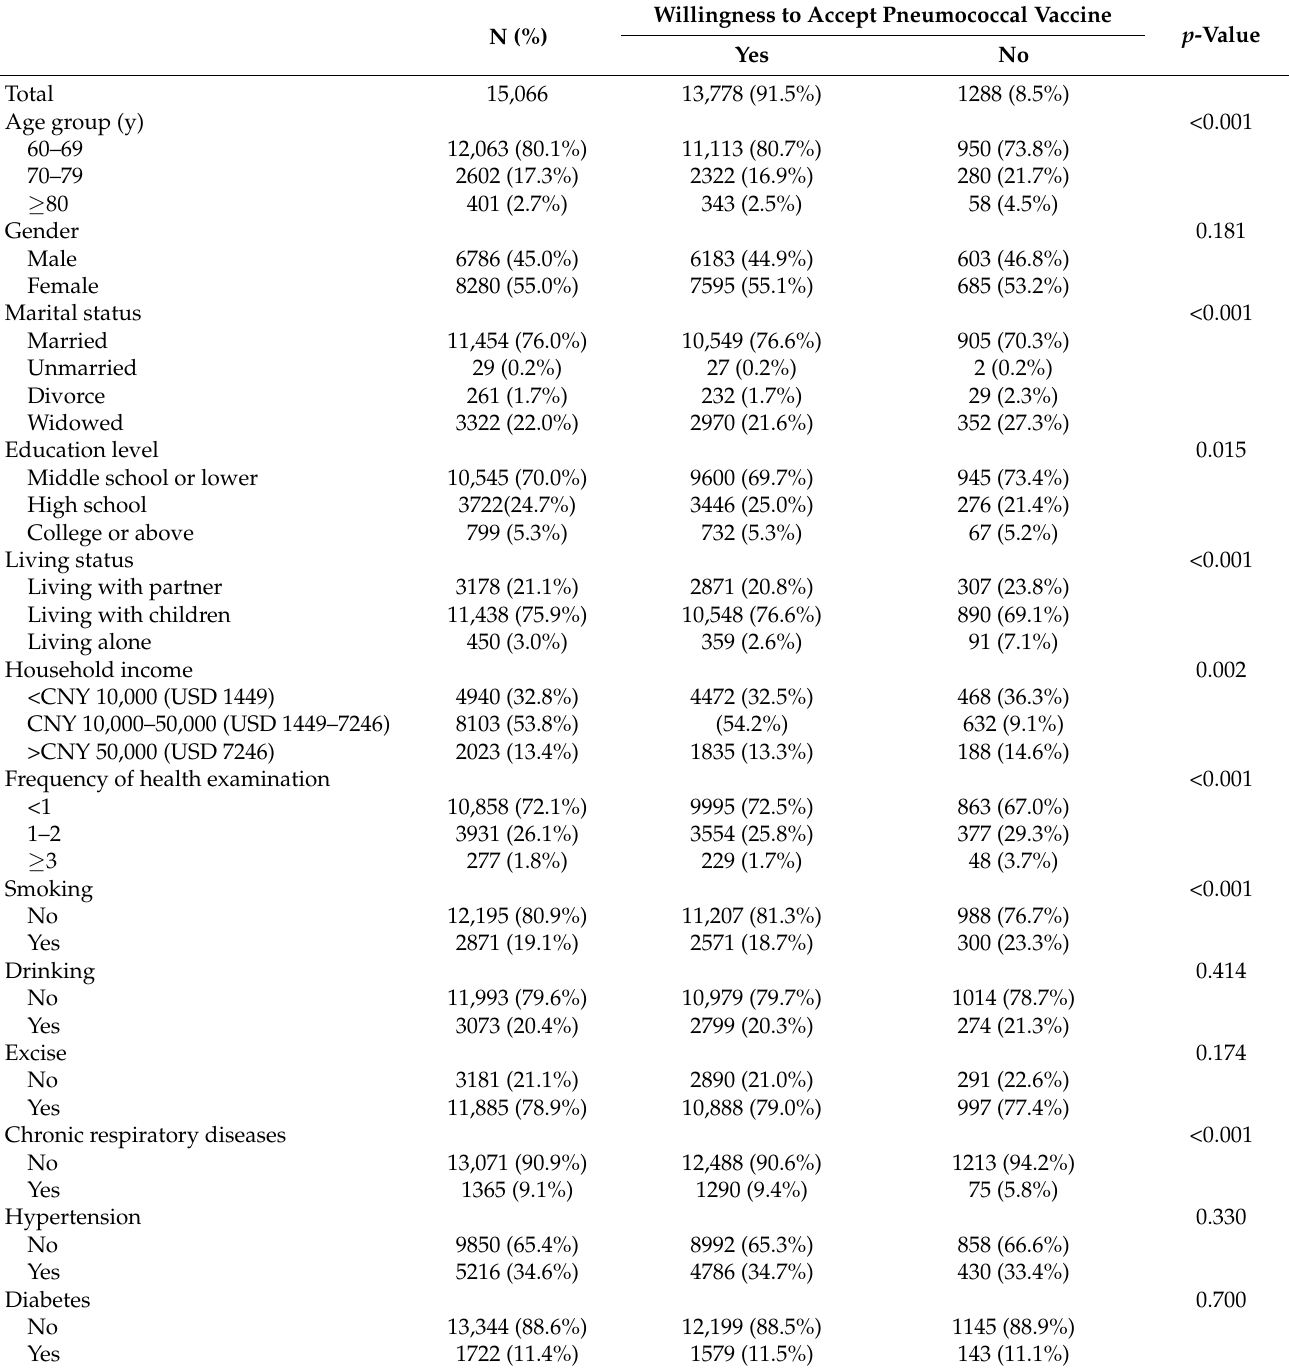
Table 1. General characteristics and health information of subjects according to the willingness to accept pneumococcal vaccine, Shenzhen, October